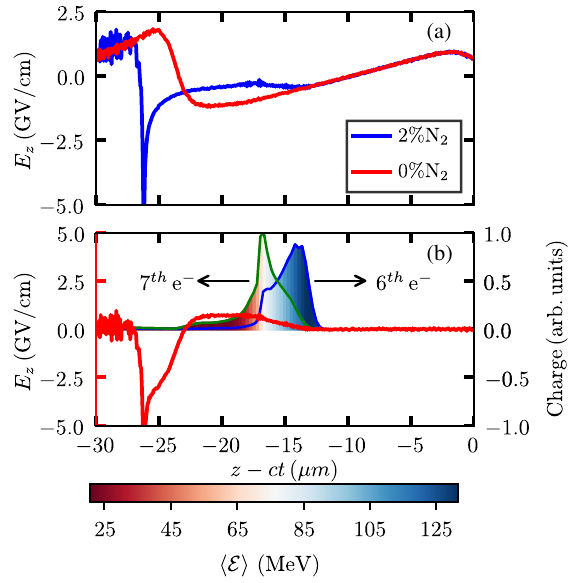
FIG. 4. Illustration of beam loading effects taken at z ¼ 3 . 3 mm. (a) E z fields with 2% of N 2 in blue solid curve and with 0% of N 2 in red solid curve with respect to z − ct ; (b) Beam loaded electric field in red solid curve given by subtracting E z fields with 0% of N 2 from the one with 2% of N 2 . In blue solid line is the charge distribution of the 6th electrons and in green solid line is the charge distribution of the 7th electrons. The color bar represents the average energy distribution of electrons, with a bin size along z − ct of 0 . 7 μ m. High energy electrons are located at the front of the